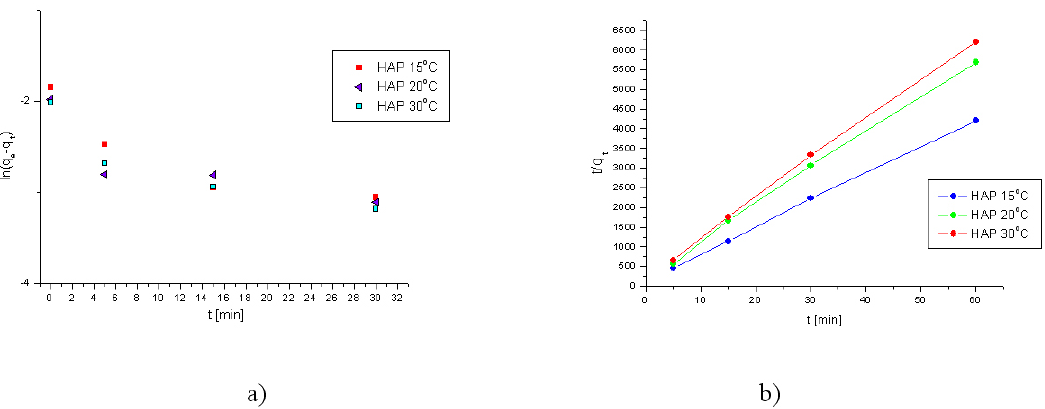
Figure 7. The applicability of the pseudo-first order kinetic model (a) and pseudo-second order kinetic model (b) to nicotinic acid adsorption on hydroxyapatite